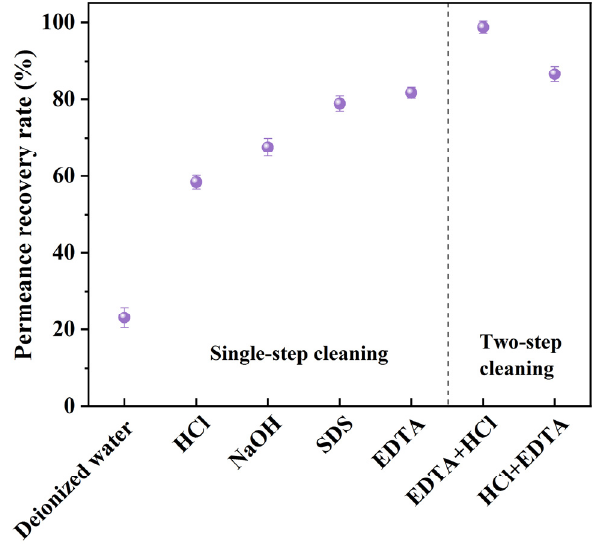
Figure 6. Permeance recovery rates after different cleaning